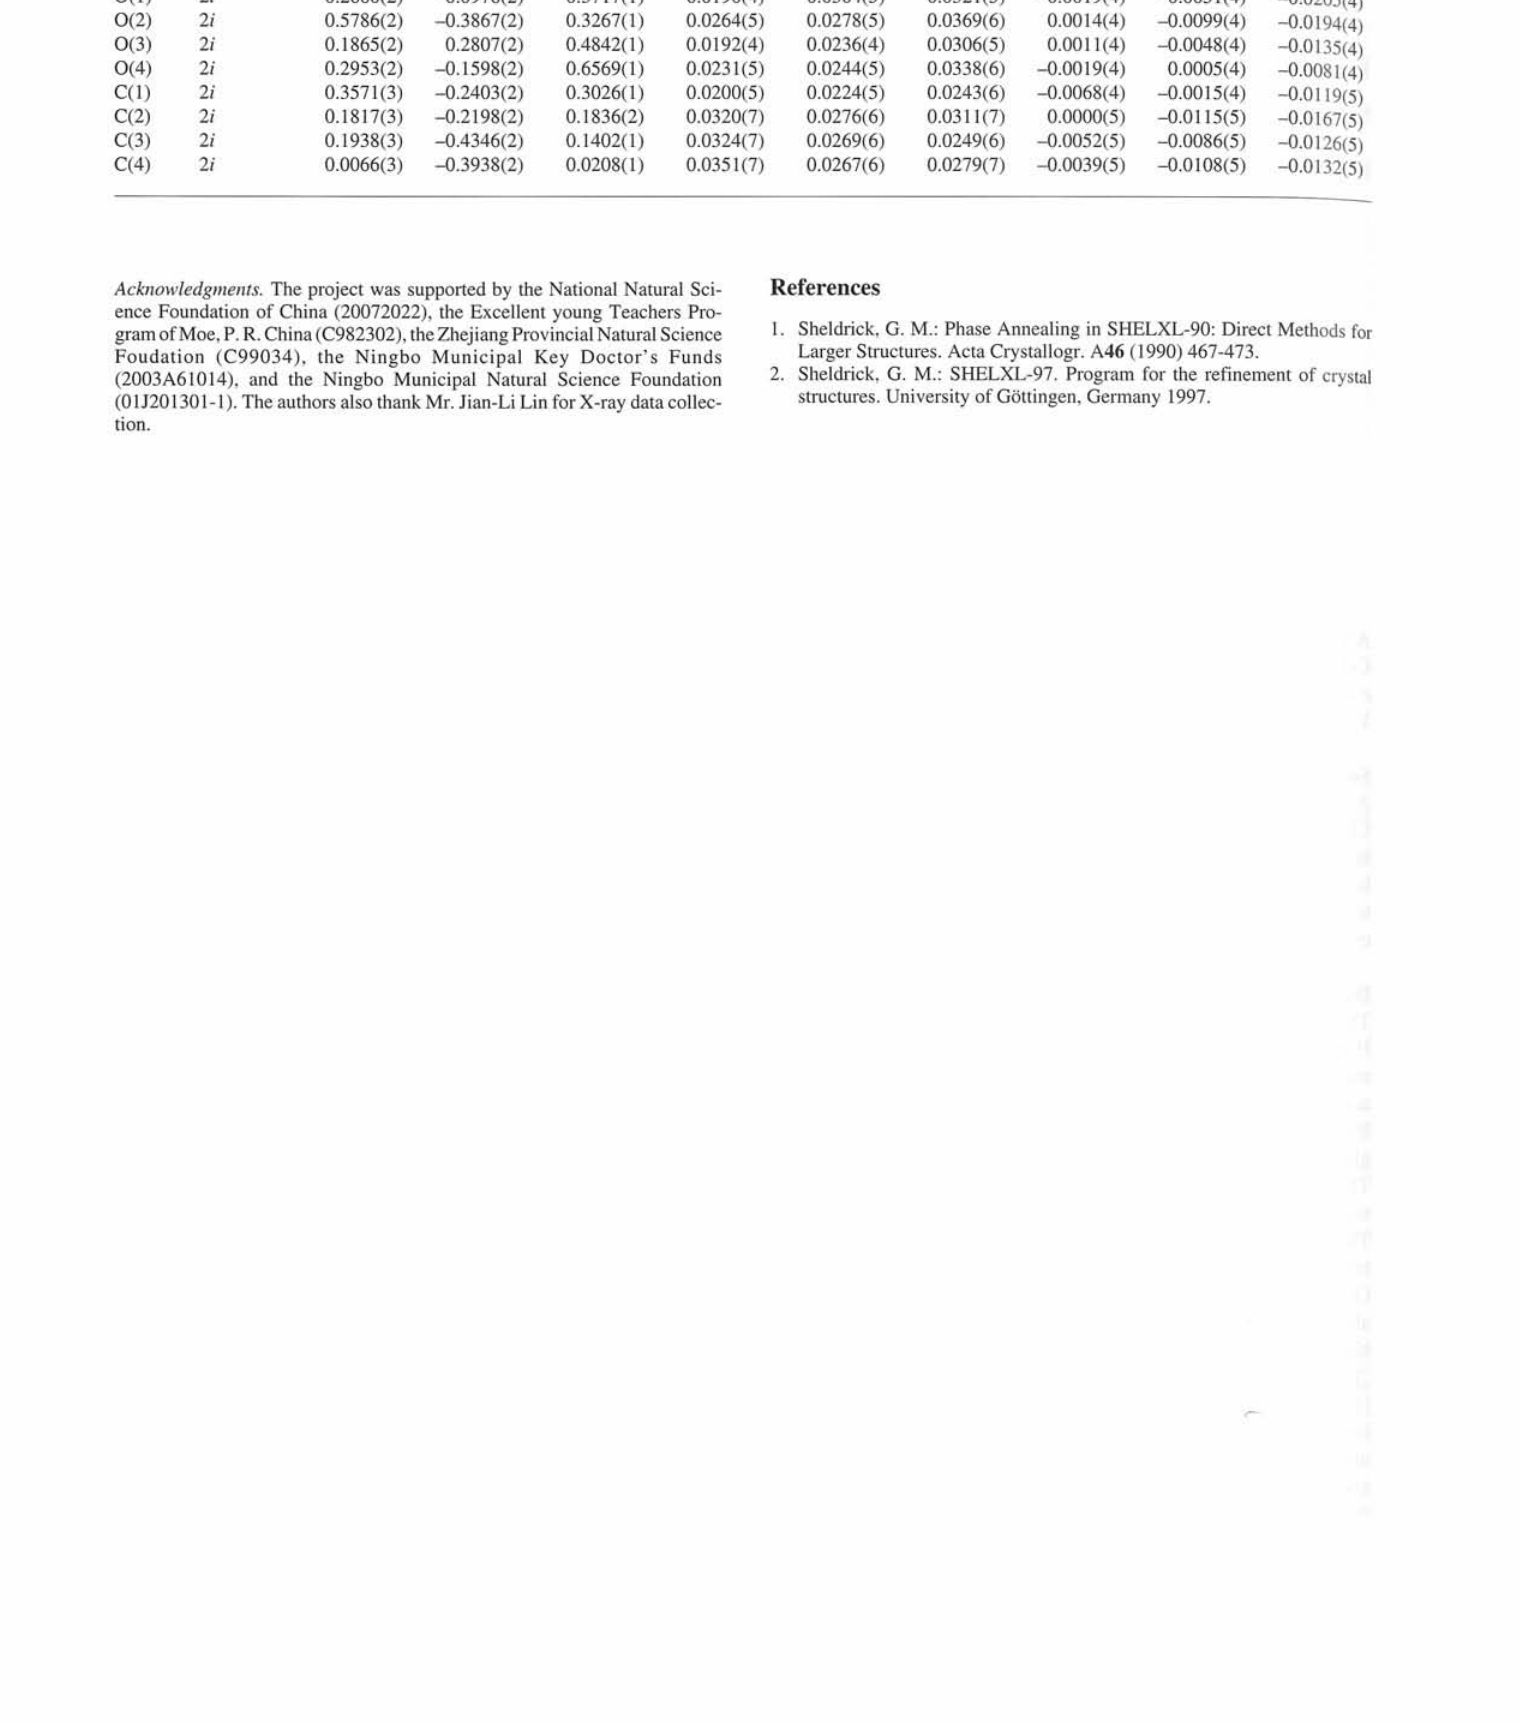
Table 3. Atomic coordinates and displacement parameters (in